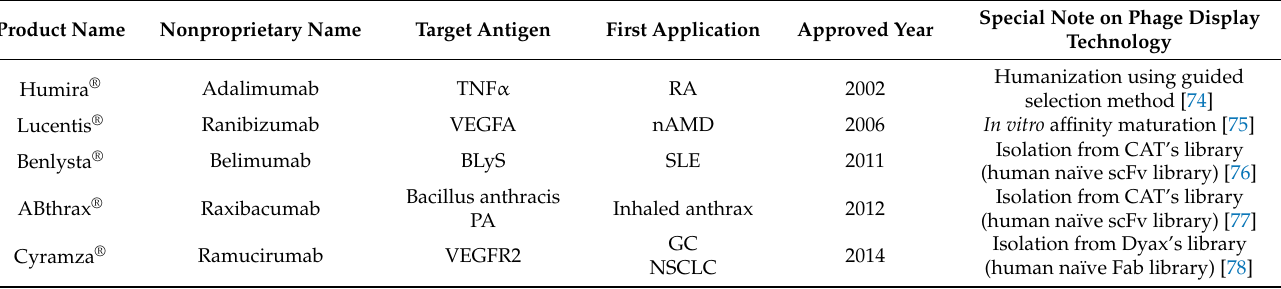
Table 1. Summary of currently available therapeutic agents derived using phage display